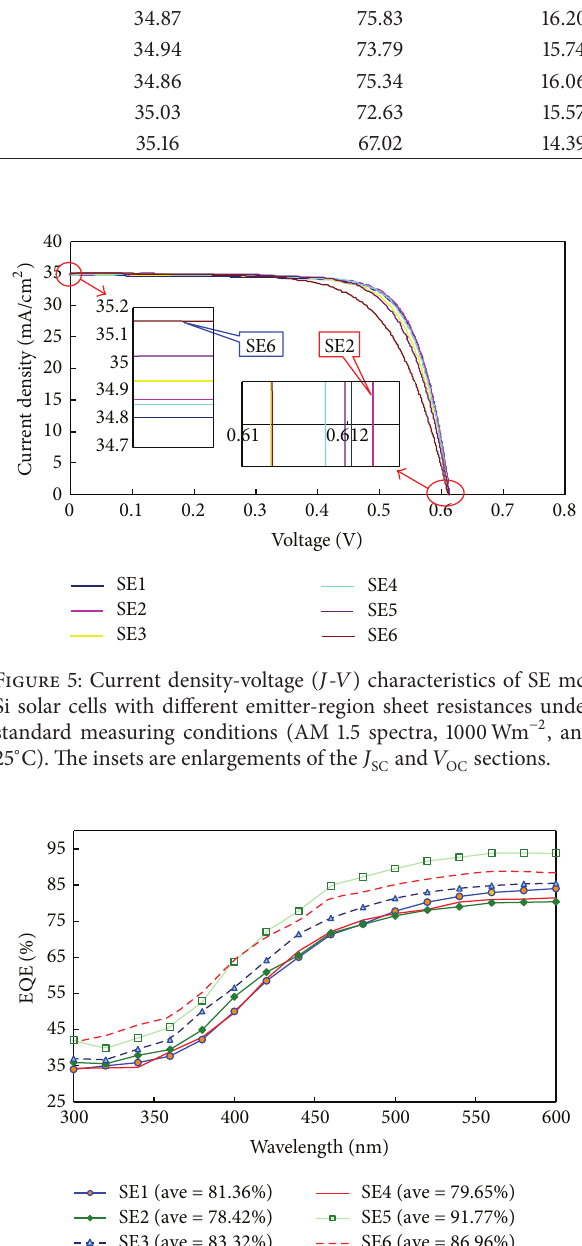
Figure 6: External quantum efficiency (EQE) and their average values for six different SE samples for short-wavelength (300– 600 nm)